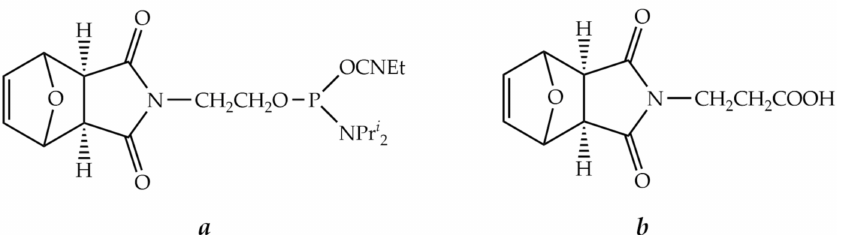
Figure 19. Oxanorbornene derivatives for the introduction of a masked maleimide into oligonu- cleotides ( a ) or peptides ( b ). CNEt— β -cyanoethyl